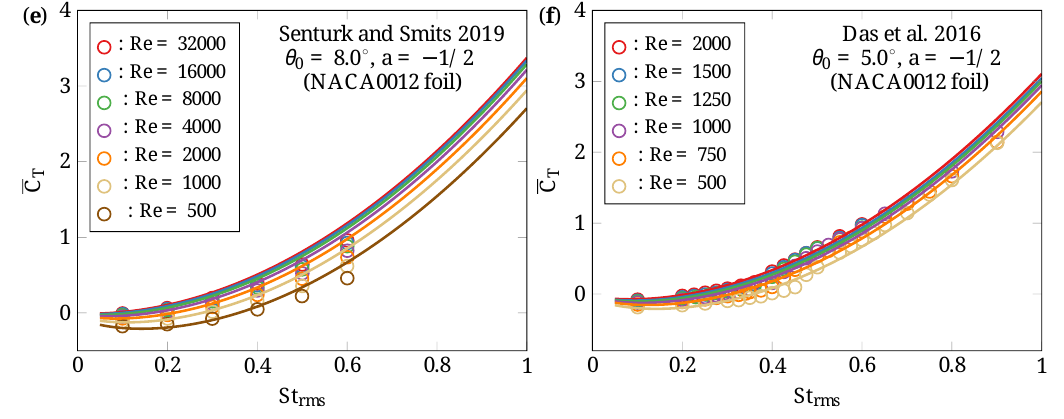
Figure 2. Mean thrust coefficient C T as a function of the root mean square Strouhal number St rms . Differentially shaped symbols represent single-mode sinusoidal ( ), and multimodal triangle-shaped ( ) and square-shaped ( ) pitching waveforms. Solid lines represent predictions from the Reynolds number and pivot location specific C T - St rms relation (45). Color variations are used to distinguish between cases associated with distinct Re and θ 0 . In panel ( a ) theoretical predictions are compared with two-dimensional computational results of Lu et al. [9] for a NACA0012 foil pitched about its quarter chord at Re = 13,500 and at three distinct pitching amplitudes. Panels ( b – f ) depict similar comparisons with previously published results. Panel ( b ) depicts comparison with the experimental results of Van Buren et al. [10] for a tear drop shaped foil pitched about its leading edge at Re = 4870 and seven distinct pitching amplitudes, panel ( c ) with the experimental results of Balla [35] for a NACA0012 foil pitched about its quarter chord at a fixed angular amplitude of θ 0 = 15 ◦ and seven distinct Re , and panel ( d ) with the experimental results of Mackowski and Williamson [36] at Re = 16,600 and Bohl and Koochesfahani [37] at Re =12,600 for a NACA0012 foil pitched sinsusoidally about its quarter chord. Panels ( e , f ) compare the theoretical prediction (45) with the computational results of Senturk and Smits [24] and Das et al. [20], respectively, for a NACA0012 foil pitched sinsusoidally about its quarter chord over a range of Re and a fixed angular amplitude ( θ 0 = 8 ◦ and θ 0 = 5 ◦ in Senturk and Smits [24] and Das et al. [20],